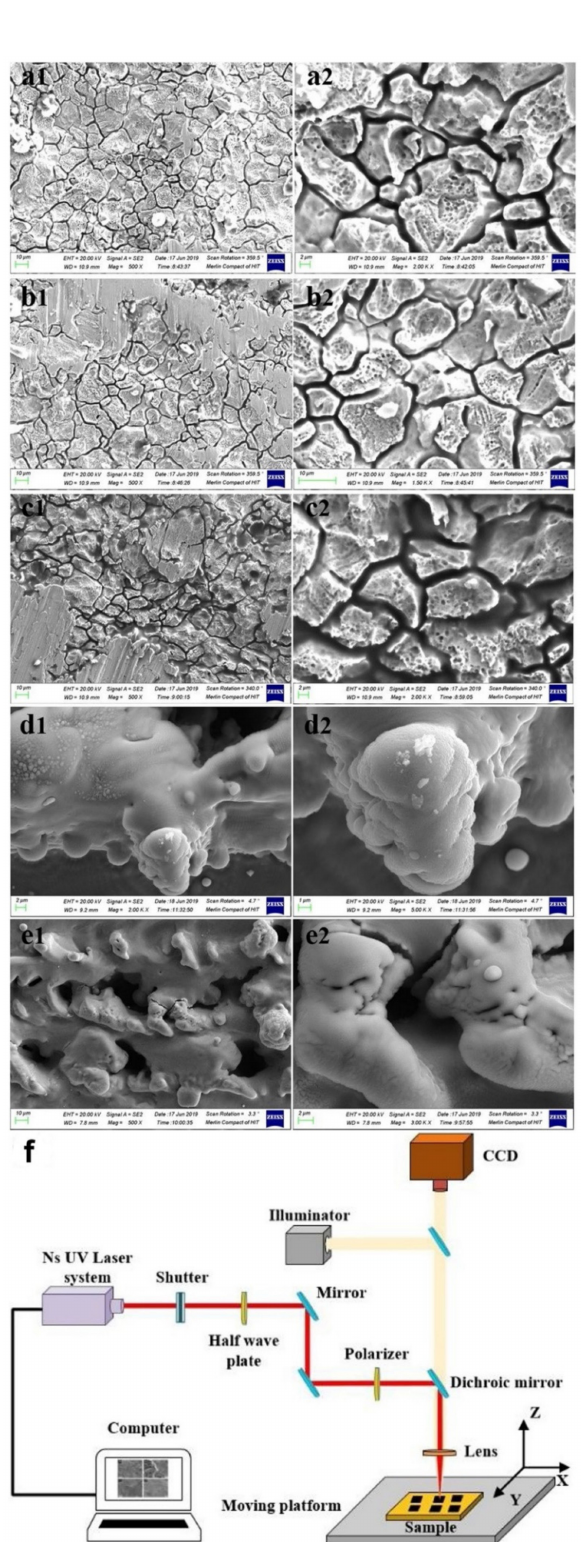
Figure 18. SEM images of laser textured surface at scanning speed of 20 mm/s with different fluence ( a ) 2.69 J/cm 2 ( b ) 3.96 J/cm 2 ( c ) 6.28 J/cm 2 ( d ) 8.14 J/cm 2 ( e ) 9.55 J/cm 2 , ( a2 – e2 ) are magnified SEM images, respectively. ( f ) Schematic illustration of a nanosecond UV laser texturing system (Reprinted from [123] with permission from